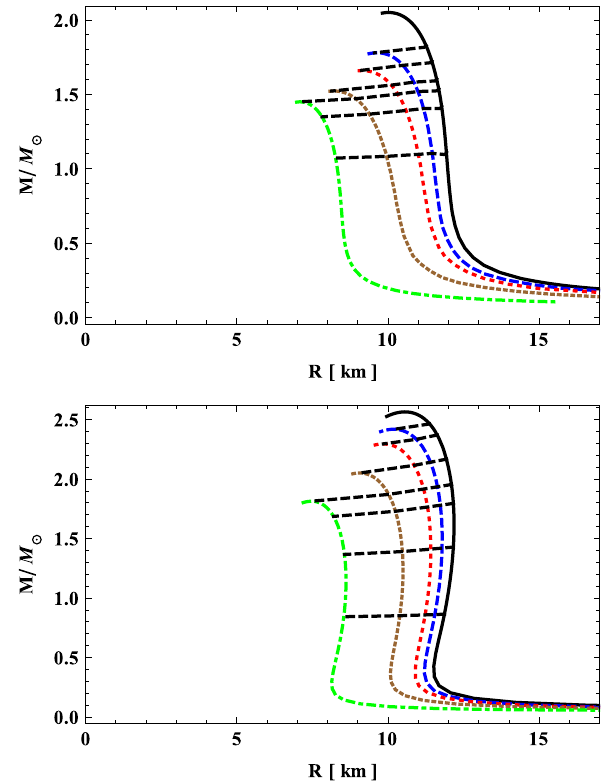
Fig. 2 Mass-radius diagrams obtained with two different EoS: Sly (upper) and joined polytropes (lower). Black solid curves correspond to initial configurations ( χ = 0) whereas blue, red, brown and green dashed curves correspond to mixed configurations respectively for χ = 0 . 5 , 0 . 6 , 0 . 75 and 1. Horizontal dashed curves indicate the evolution of a given NS with a conserved overall baryon number N O + N M = N